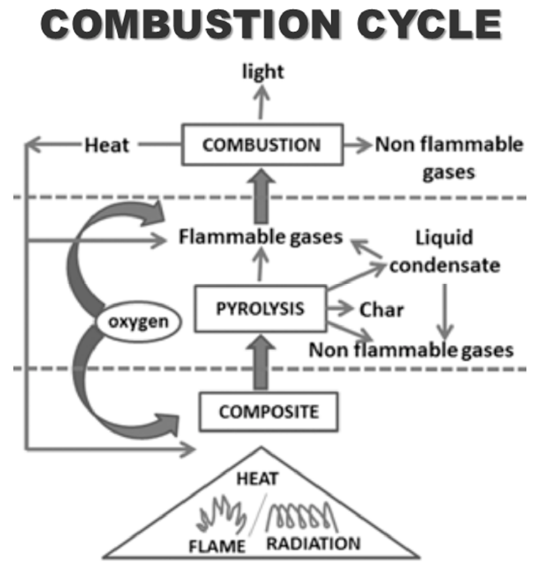
Figure 4. Flame retardancy approach and combustion cycle. Reproduced with copyright permission from Bar et al. [73], Springer.